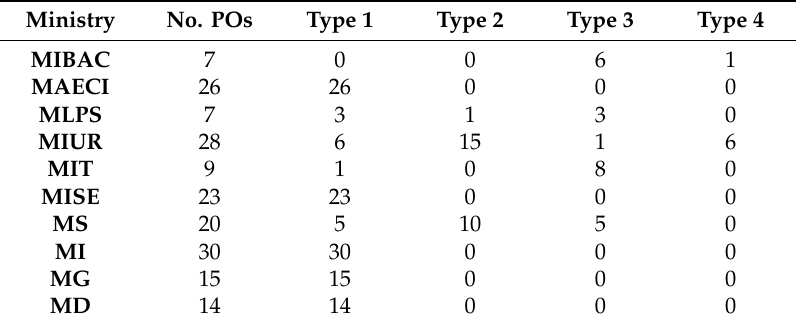
Table 4. Number of Performance Objectives (POs) per type of integration.